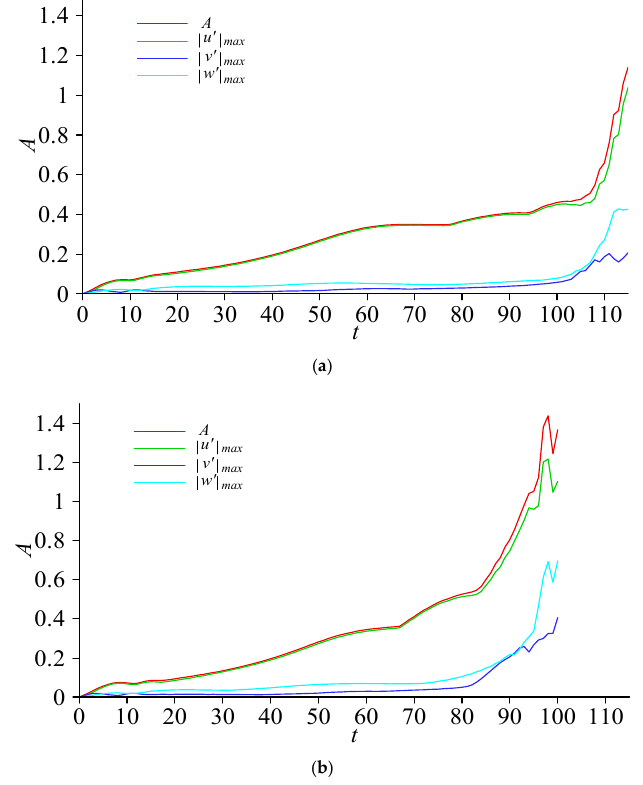
Figure 3. Maximum disturbance amplitude: ( a ) positive–negative (P–N) model; ( b ) negative–positive (N–P) model.